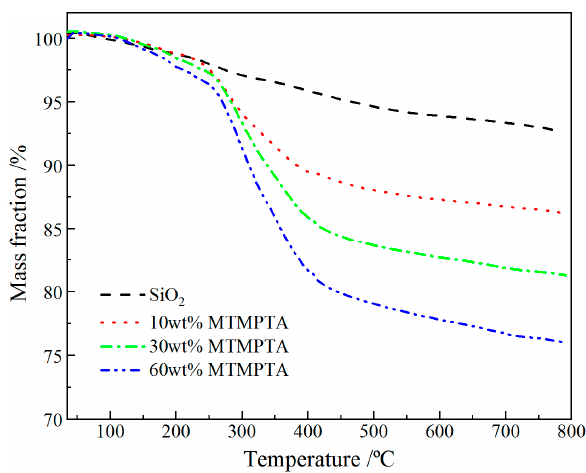
Figure 3. ( a ) Hydrogen nuclear magnetic spectrum of MTMPTA and ( b ) infrared transmission spectra of MPTMS, SiO 2 nanoparticles, TMPTA, and TMPTA-s-SiO 2 nanoparticles.